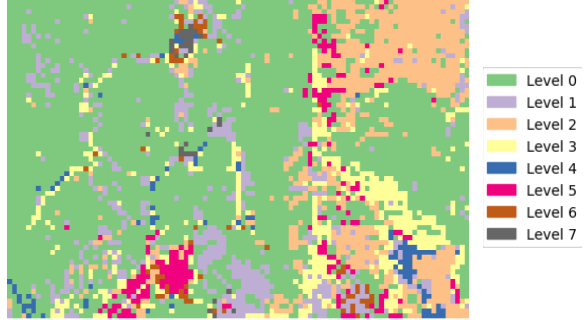
Figure 7. Changes between April 17 th and June 16 th , 2018.